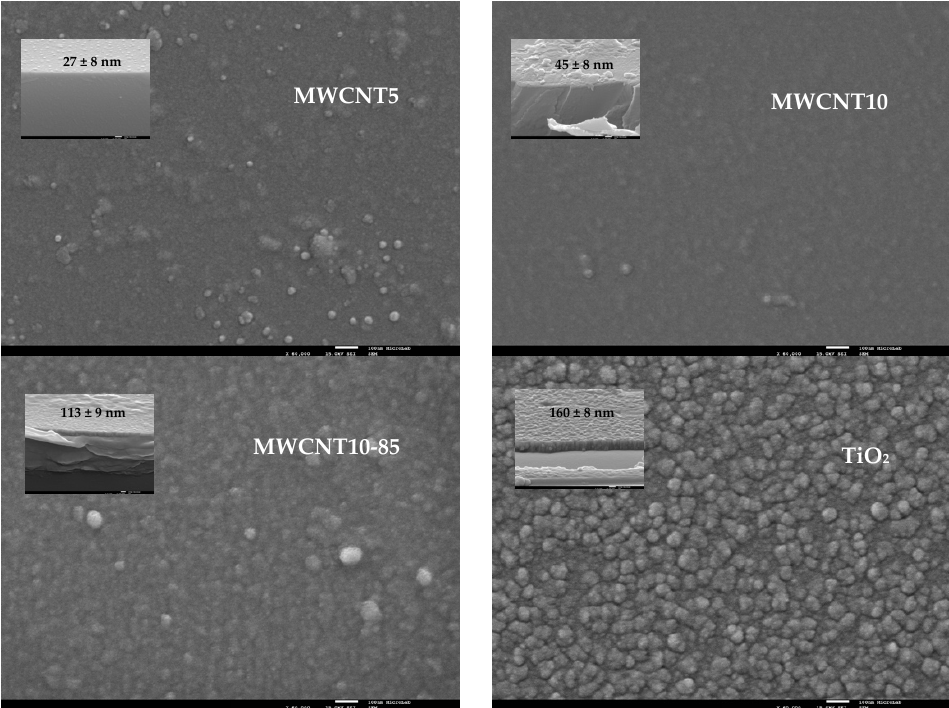
Figure 1. Scanning electron microscope (SEM) image of MWCNT5, MWCNT10, MWCNT10-85 and TiO 2 : surface and cross-section (as inset).